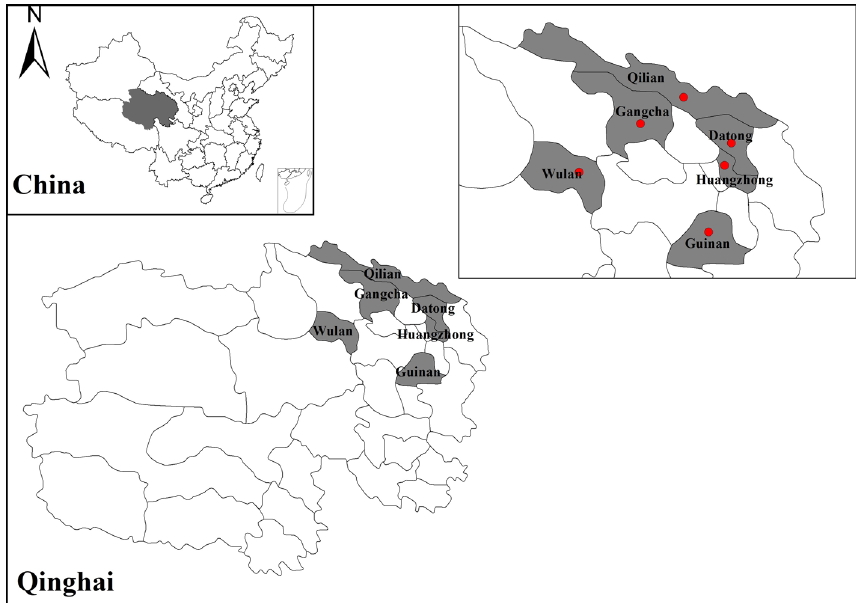
Figure 1. Map of sampling counties in Qinghai in this study. The red dots show the sampling